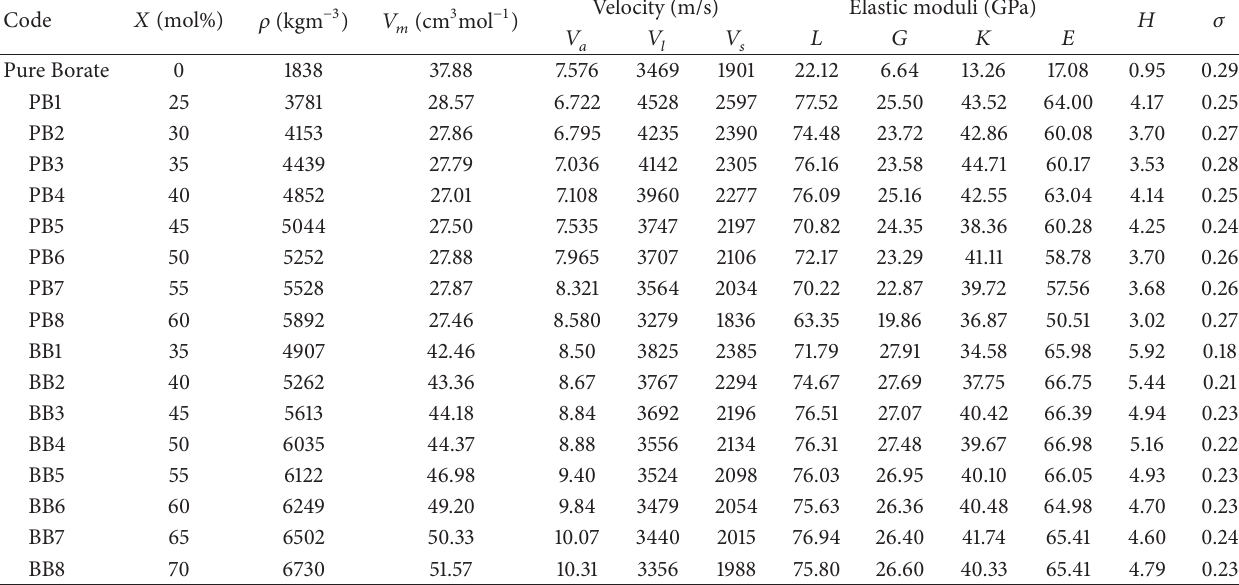
(B 2 O 3 ) 1− , BB = (Bi 2 O 3 ) (B 2 O 3 ) 1− X X X X